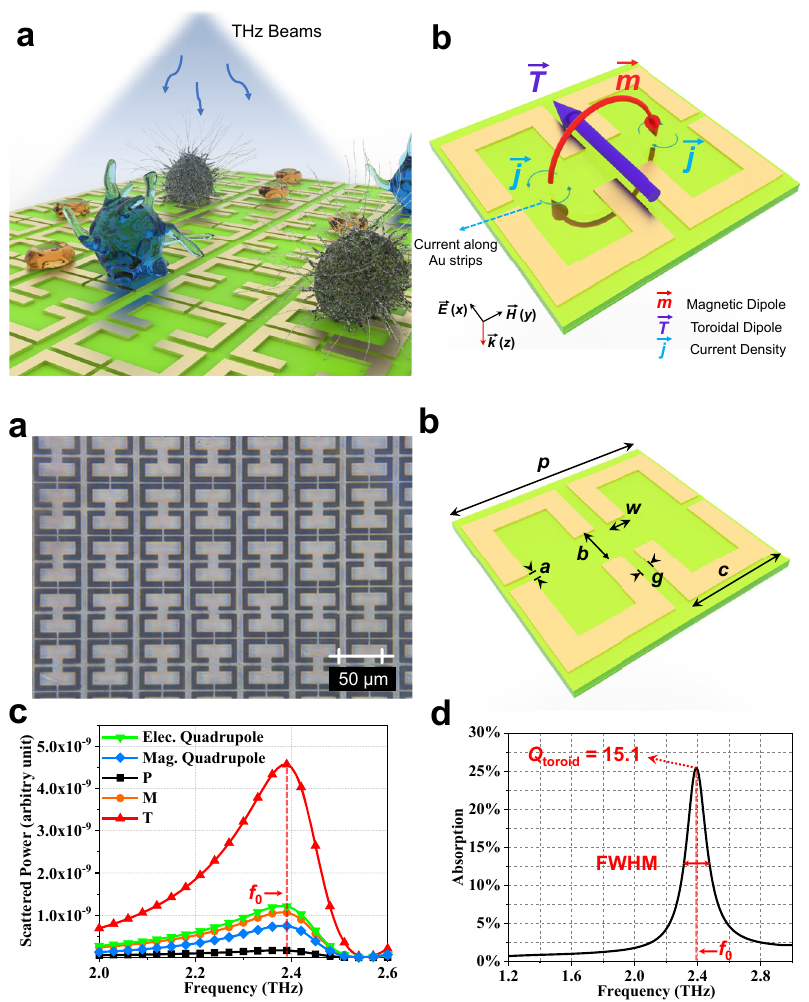
Figure 1: Schematic of the metasurface and meta-atom. (a) Three types of cells cultured on the metasurface are distinguished by the terahertz spectra. (b) Toroidal dipole generated in a pair of asymmetric gold SRRs.